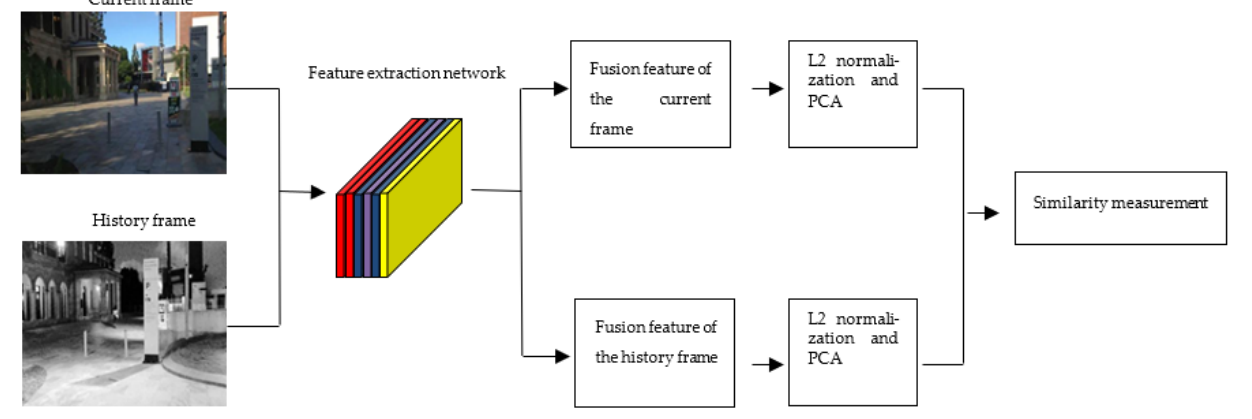
Figure 8. The flowchart of loop closure detection.